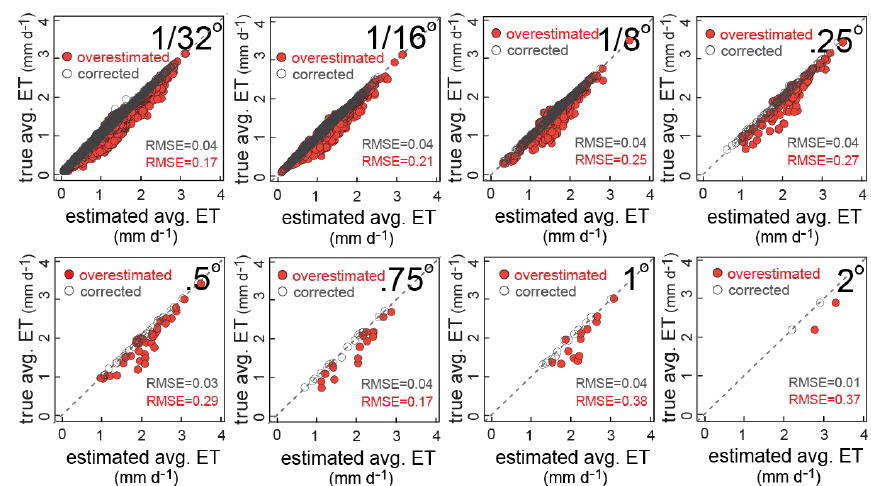
Figure 4. Daily estimated ET rates versus true average ET at each grid cell at several different grid scales (example day, 31 May 2004). The solid red symbols demonstrate the relationships between true average ET calculated using fine-resolution data at each grid cell and modeled grid-cell-averaged ET using grid-cell-averaged inputs in Eq. (8), for each grid cell at several different grid scales (overestimated). For comparison, the open symbols show true average versus average ET estimated by the Taylor expansion approach of Eq. (7), which corrects for sub-grid heterogeneity effects using only grid-cell-averaged estimates of the ET drivers and their small-scale variances and covariances (heterogeneity-corrected ET estimates,